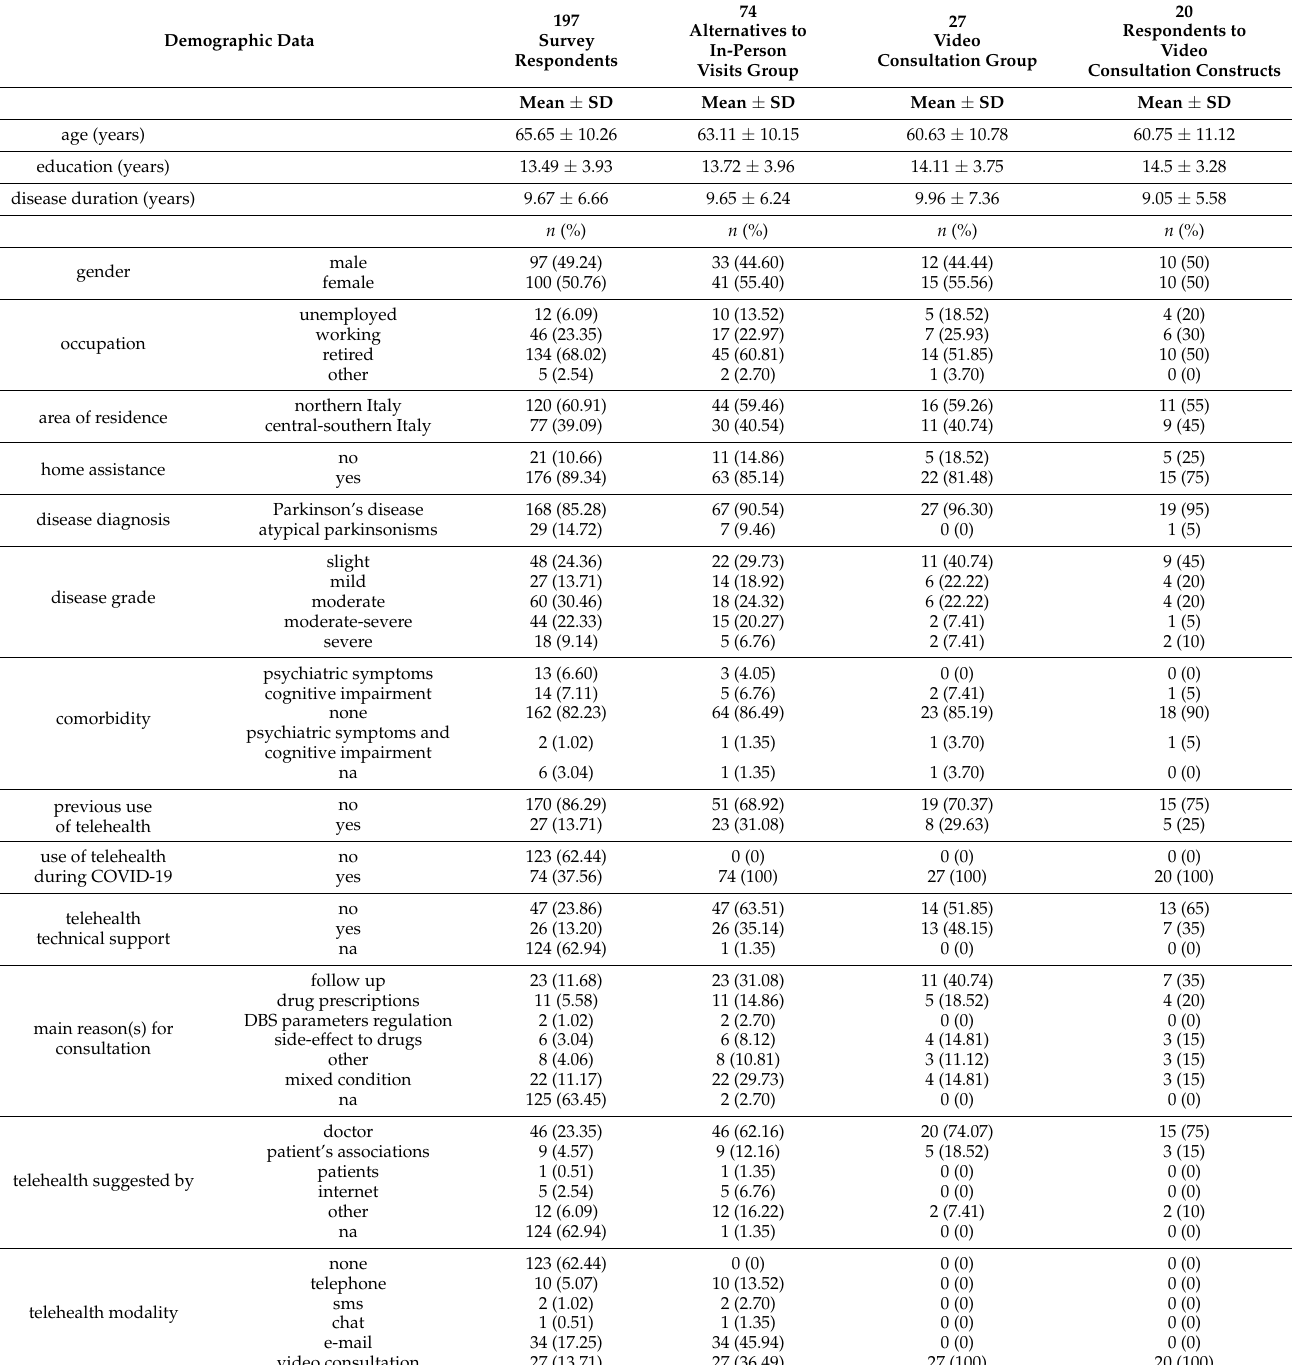
Table 2. Demographic data of PD patients and telehealth